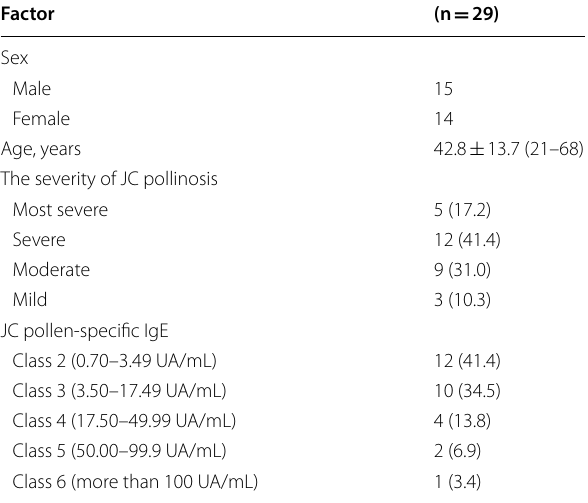
Table 1 The characteristics of 29 subjects